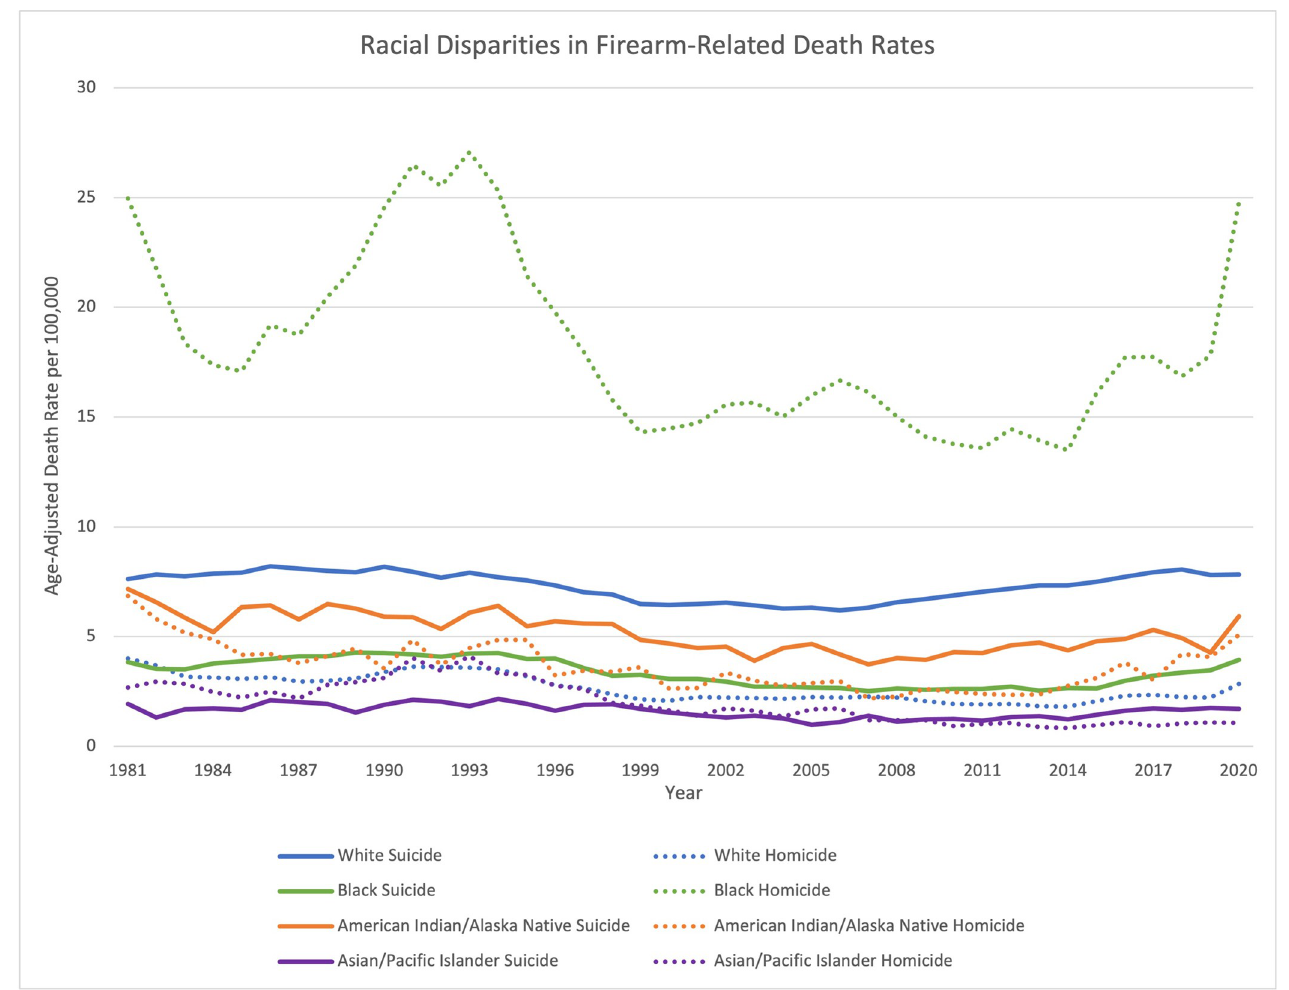
Fig 1. Yearly firearm-related age-adjusted death rates by race. Age-adjusted death rates per 100,000 for firearm-related deaths by racial groups from 1981 to 2020.